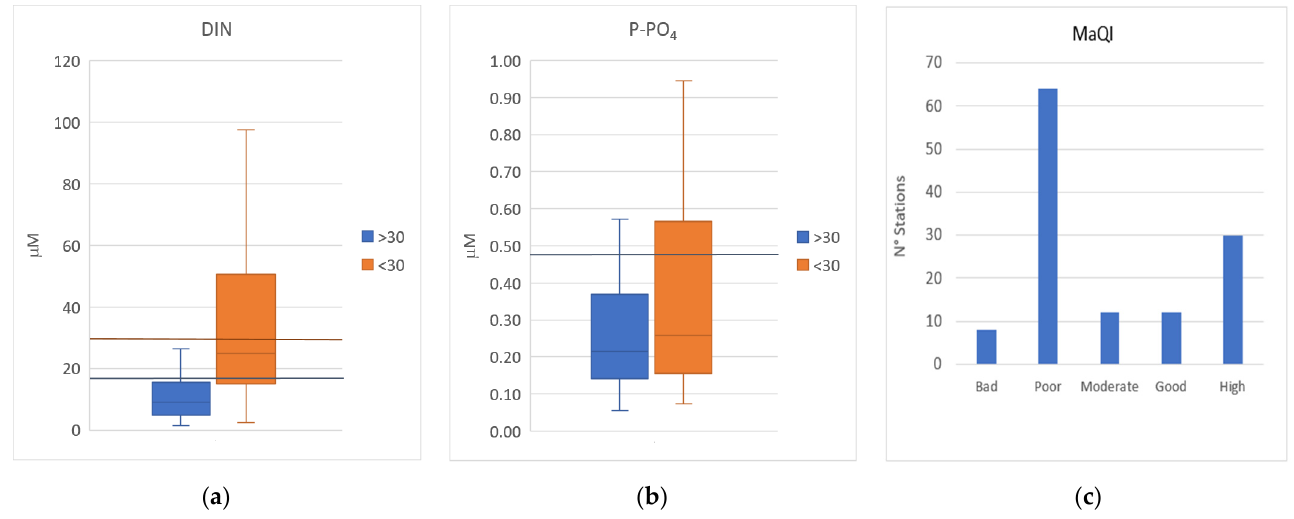
Figure 2. Distribution of data used in phase 1. ( a ) Box plots of DIN concentrations collected over three years (n = 126). Orange line indicates threshold set by Italian legislation (DM 260/2010) for water bodies with salinity <30. Blue line indicates the threshold set by Italian legislation (DM 260/2010) for water bodies with salinity >30. ( b ) Box plots of P-PO 4 concentrations collected over three years (n = 126). Blue line indicates the threshold set by Italian legislation (DM 260/2010) for water bodies with salinity >30. ( c ) Frequency of distribution of MaQI status results of the stations sampled over one year (n = 126).